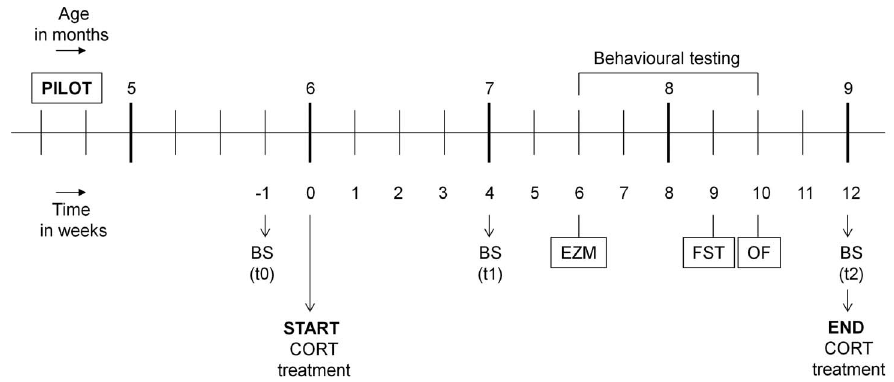
Figure 2. Schematic diagram of the different stages of the main study. BS: blood sample; CORT: corticosterone; EZM: elevated zero maze; FST: forced swimming test; OF: open field test.